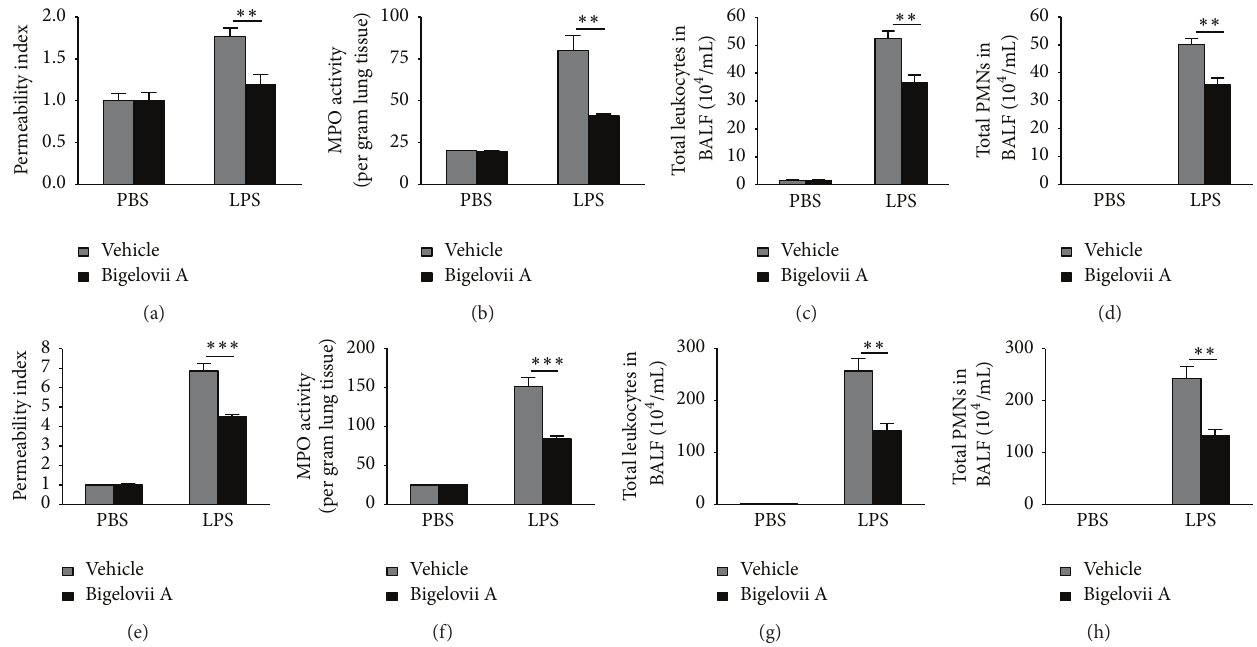
Figure 1: Effect of Bigelovii A on acute lung injury (ALI) induced by airway administration of LPS. ALI was induced by intratracheal administration of LPS. 18 h (a–d) or 60 h (e–h) later, BAL fluids were extracted, and the whole lungs were harvested. (a and e) ELISA was conducted to detect mouse albumin levels in BAL fluids, and the permeability index was expressed as the ratio of the albumin in the LPS- treated lungs versus that in the PBS-treated lungs of same type of mice. (b and f) MPO contents in whole lung tissues were determined. Total cell (c and g) and neutrophil (d and h) accumulation in BAL fluids were estimated. Results are reflected by means ± SEM [ 𝑛 = 3 for Vehicle plus PBS group (negative control) or Bigelovii A+PBS group, 𝑛 = 6 for LPS+Vehicle group (positive control), and 𝑛 = 5 for LPS+Bigelovii A group]. ∗∗ and ∗ ∗ ∗ indicated statistically significant difference, 𝑝 < 0.01 and 0.001,